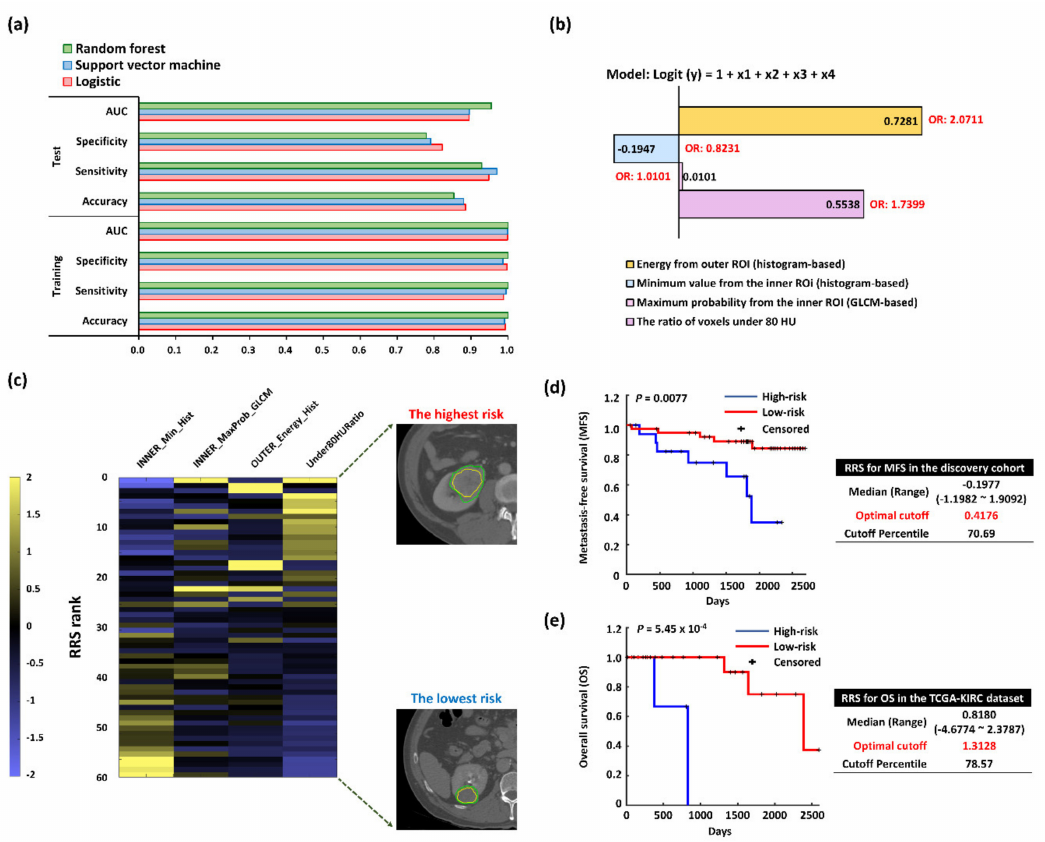
Figure 2. Performance evaluation of the selected features and risk assessment-based radiomics for postsurgical metastasis in pathologic stage T1 renal cell carcinoma. ( a ) Classification performance measures for the selected features. Each performance value was an average of 10,000 bootstrap samples. ( b ) Importance of each finally selected feature using multivariate logistic regression. GLCM, gray-level cooccurrence matrix; ROI, region of interest. Four features were selected to build the radiomics signature using the LASSO logic regression model, and the radiomics score for each patient was